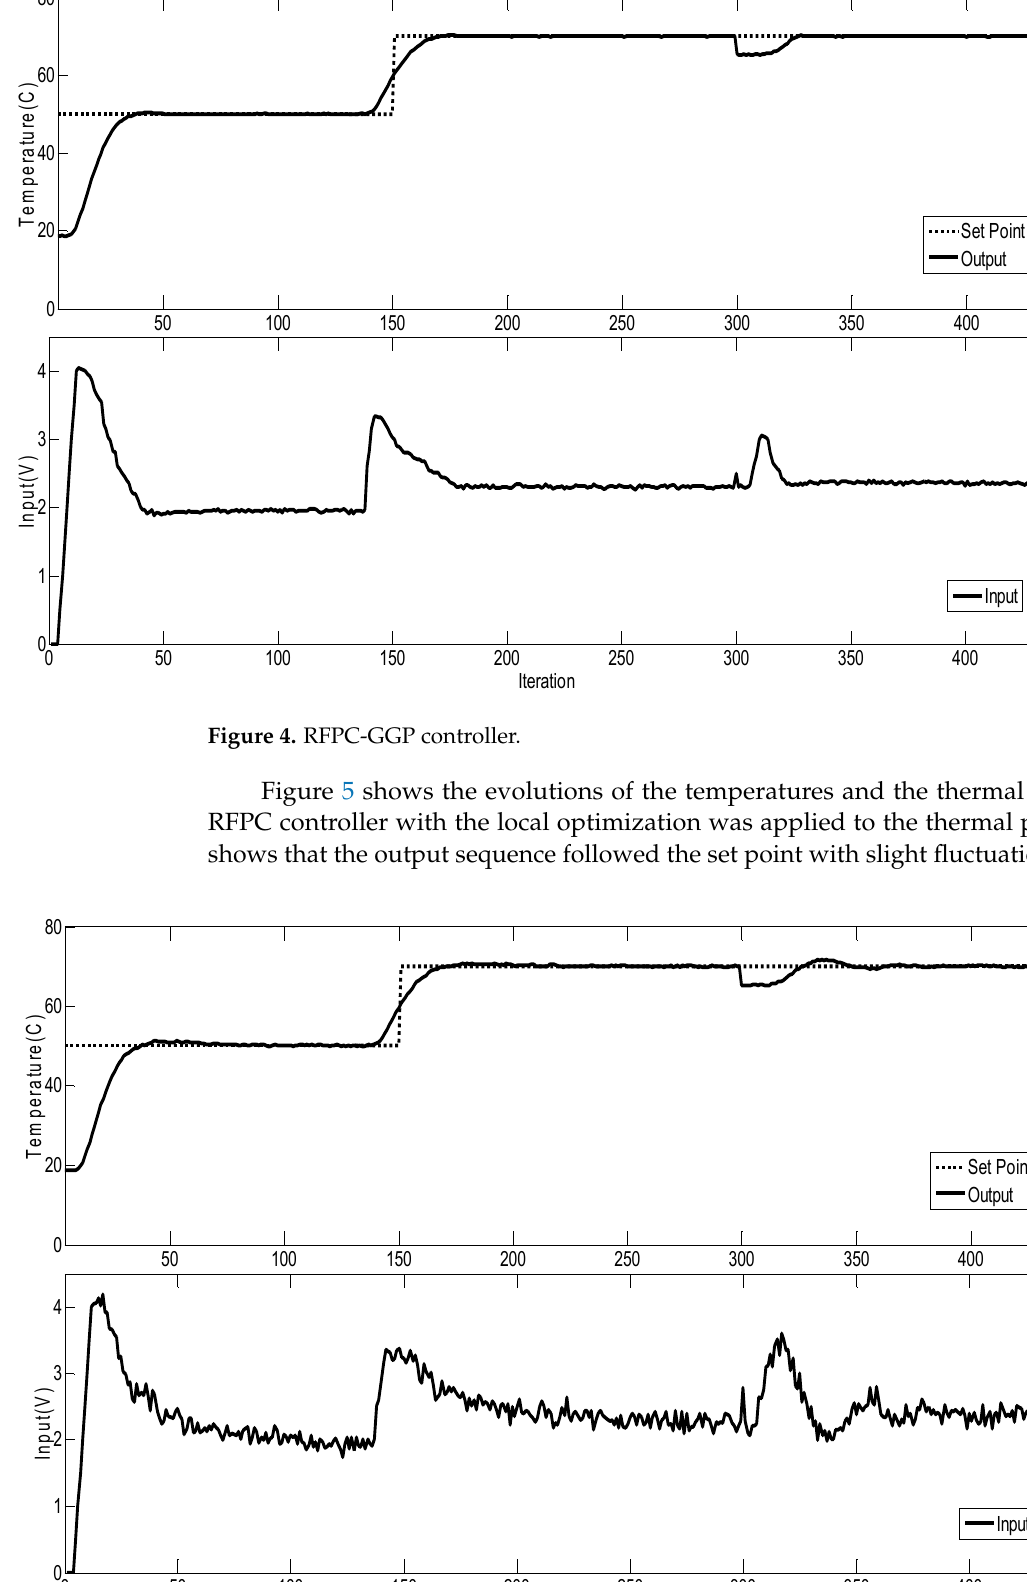
Figure 5. RFPC based on the local optimization